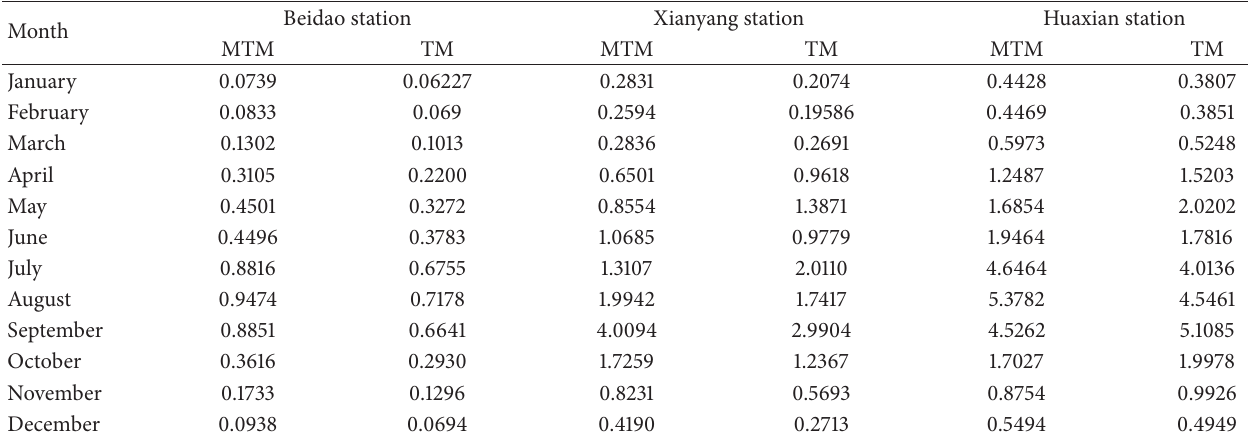
Table 3: The minimum instream ecological flow of the Wei